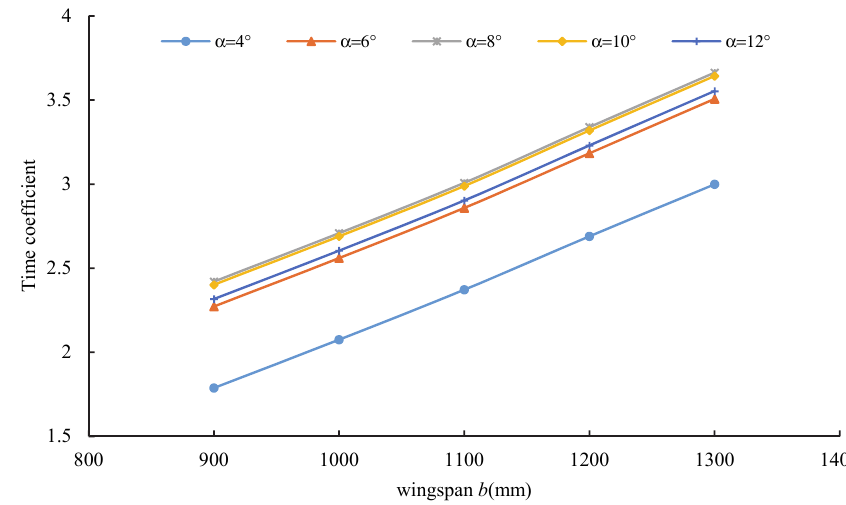
Figure 10. Relationship between the wingspan and time coefficient.